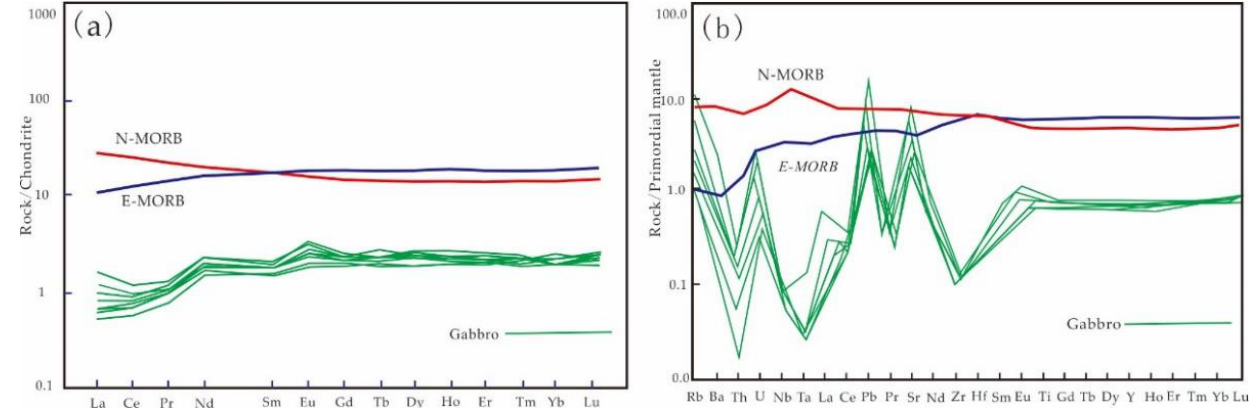
Figure 6. ( a,b ) Chondrite-normalized REE and primitive mantle-normalized trace element distribu-